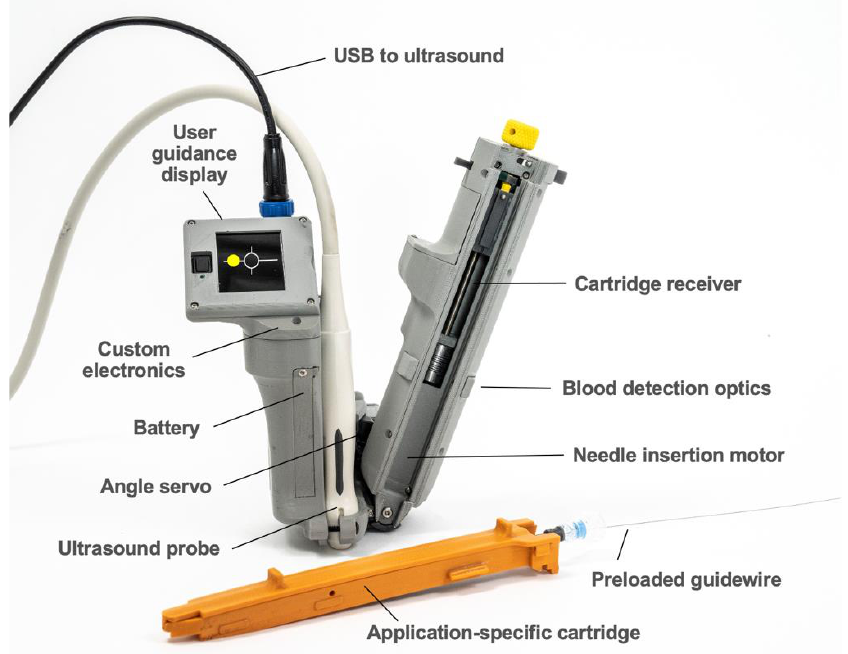
Figure 2. AI-GUIDE handheld robotic